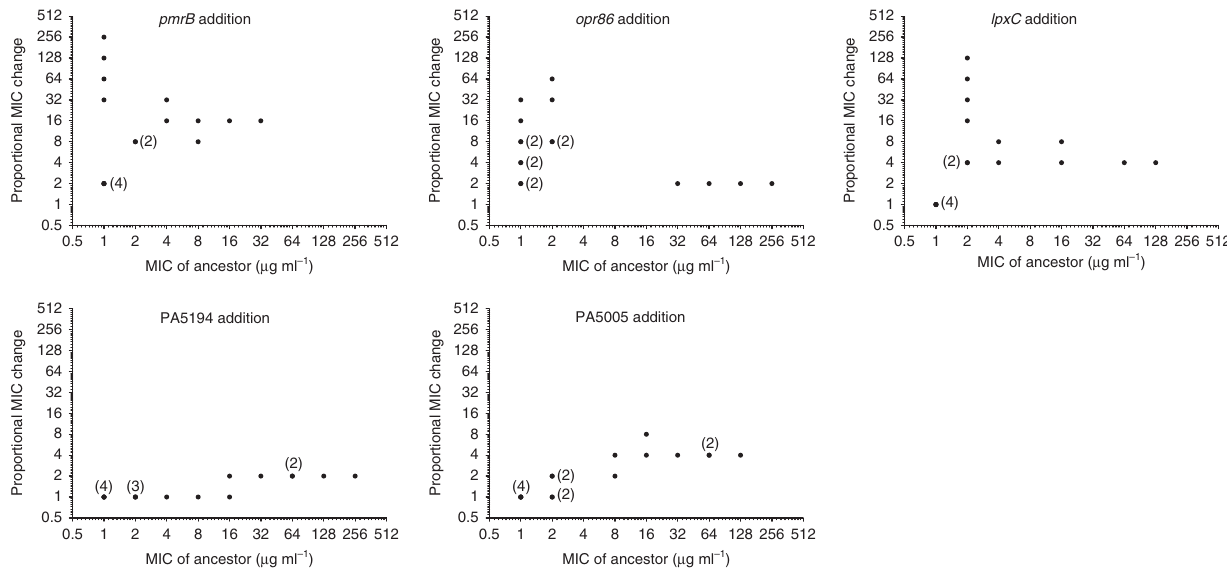
Figure 4 | Epistasis in colistin resistance evolution. Graphs show proportional MIC change in 16 allelic backgrounds with increasing MIC upon addition of mutations in pmrB , opr86 , lpxC , PA5194 or PA5005 from the colistin-resistant strain SNRC. Each point represents a single strain. In some cases, points are on top of each other as indicated by the numbers in parentheses. Colistin MIC was determined by microbroth dilution assay and presented as the median of at least three biological replicates.